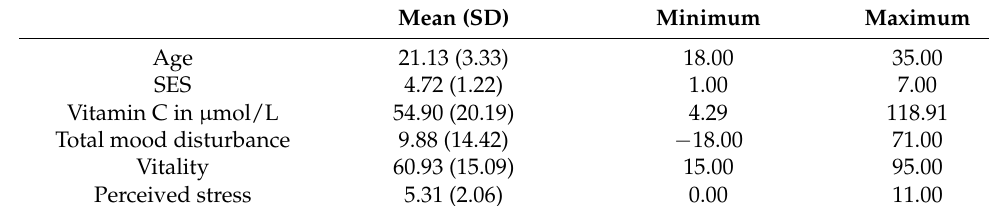
Table 2. Sample characteristics ( n =